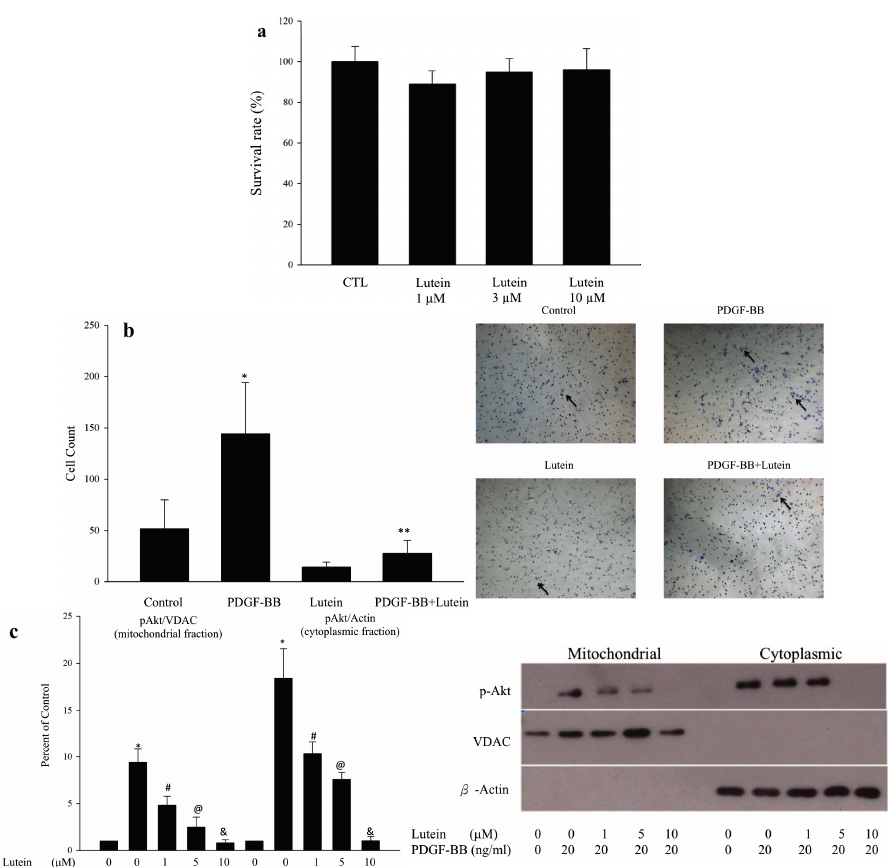
Figure 1. ( a ) MTT assay of lutein. No significant cytotoxicity of lutein was noted up to concentrations of 10 μ M; ( b ) Transwell migration assay and cell count bar graph. PDGF can increase migration of RPE cells, and lutein at the concentration of 10 μ M can inhibit the PDGF-induced migration of RPE cells. Transwell migration assay was performed as described in the Materials and Methods section. Migration was quantified by counting the number of stained cells per 100 high power field (HPF) in images taken with a phase-contrast microscope. Black arrow indicates the migrated RPE cells. Cell count bar graph was made from four independent repetitions of the experiments. * p < 0.001 vs. control, ** p < 0.001 vs. PDGF-BB; ( c ) The Western blot showed that phospho-Akt increases in both mitochondrial and cytoplasmic compartment under PDGF-BB stimulation (20 ng/mL). The stimulatory effect was inhibited by lutein in a dose dependent manner. The bar graph represented the data summarized from four experiments. The data were normalized to the contents of voltage-dependent anion channel (VDAC) in mitochondrial fraction and actin in cytoplasmic fraction. * p < 0.01 vs. control; # p < 0.01 vs. lutein 0 μ M; @ p < 0.05 vs. lutein 1 μ M; & p < 0.05 vs. lutein 5 μ